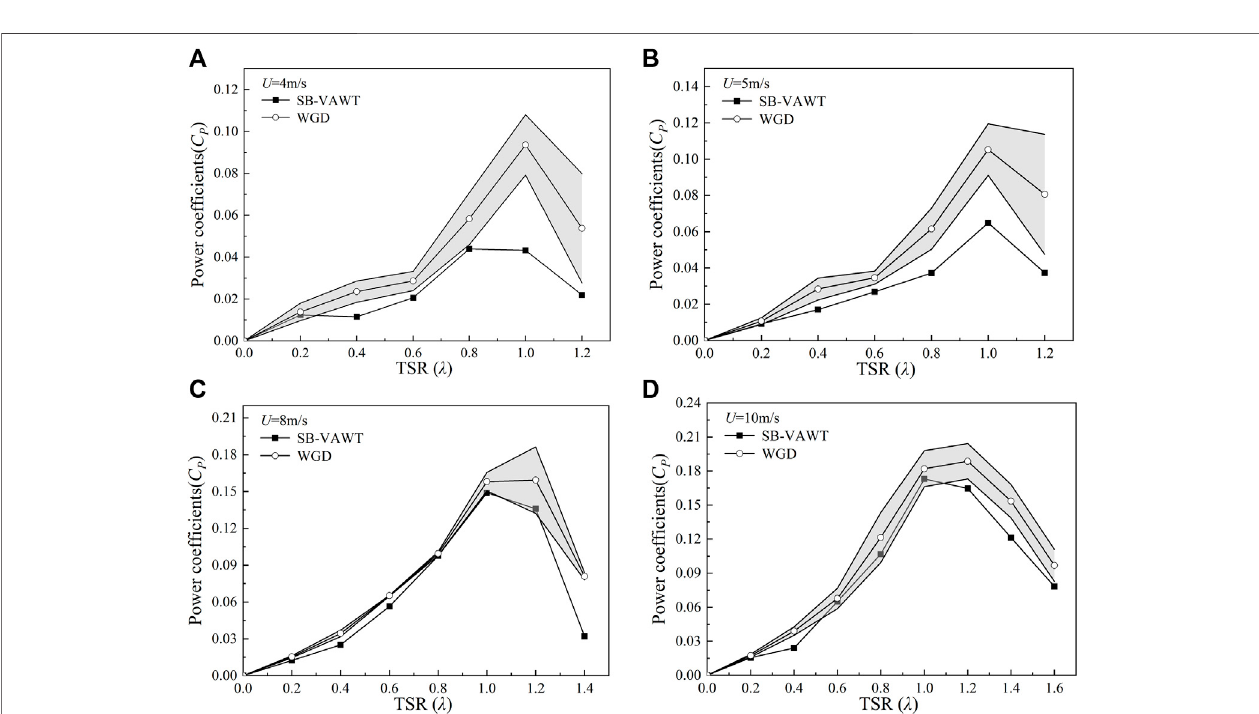
FIGURE 10 | Power coef fi cients of the rotor with and without the WGD by wind tunnel tests.